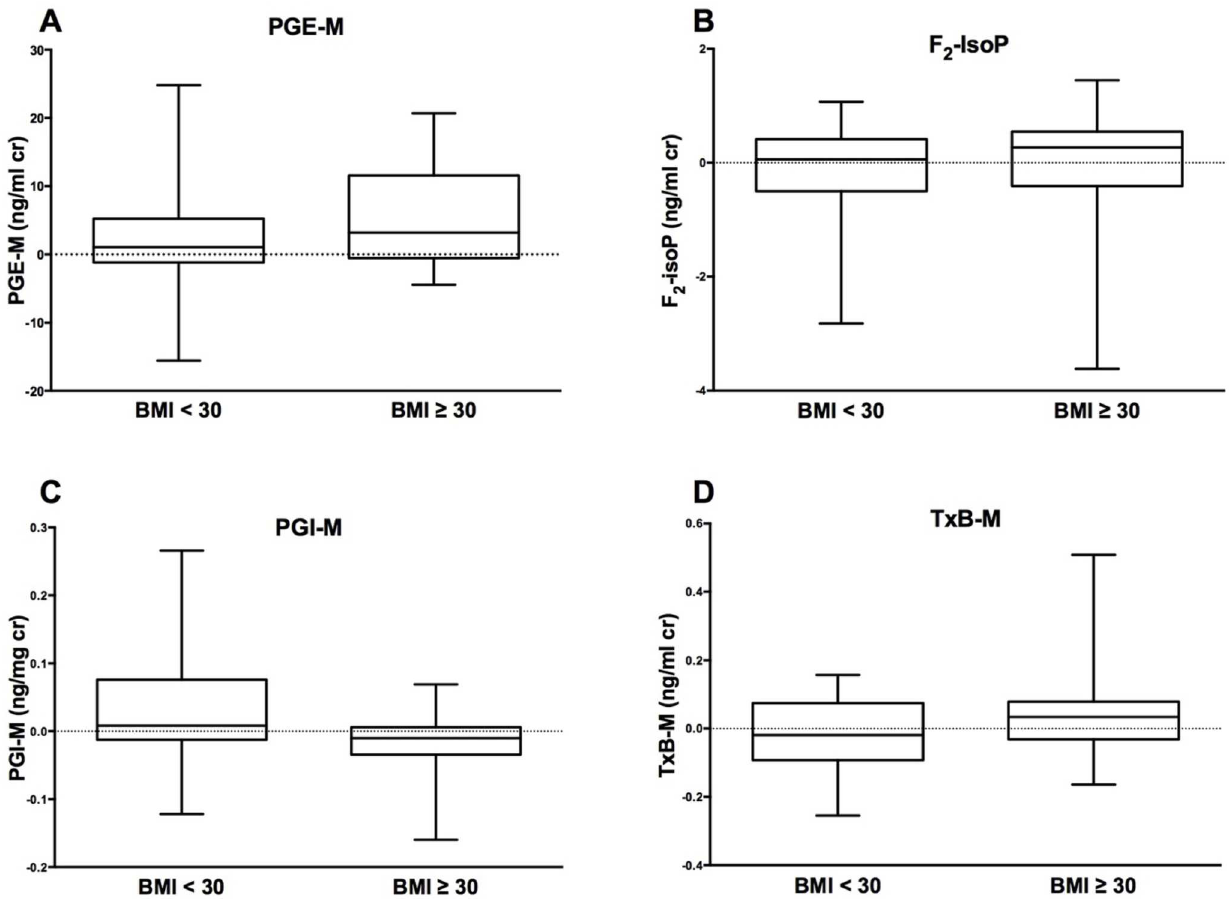
Fig 2. Change in urine eicosanoid levels after 24 weeks of telmisartanby BMI. Panel A: Box and whisker plot of urine PGE-M levels (ng/ mg cr). Maximum and medium values are denotedby whiskers and solid line, respectively.Mann-Whitney U p = 0.40. Panel B: Box and whisker plot of urine F 2 -IsoP levels (ng/mg cr). Mann-Whitney U p = 0.52. Panel C: Box and whisker plot of urine PGI-M levels (ng/mg cr). Mann-Whitney U p = 0.04. Panel D: Box and whiskerplot of urine TxB-M levels (ng/mg cr). Mann-Whitney U p = 0.31. (rho = 0.48, p = 0.003 and rho = 0.35, p = 0.04 respectively). TxB-M/PGI-M ratio was inversely correlated with high-density lipoprotein (HDL) cholesterol levels (rho = -0.38, p = 0.03). Sub- group analyses by sex revealed heterogenous results with no notable correlations observed in females. Men saw a relationship with low-density lipoprotein (LDL) cholesterol levels and both F -isoP (rho = 0.53, p = 0.02) and TxB-M (rho = 0.46, p = 0.04). 2